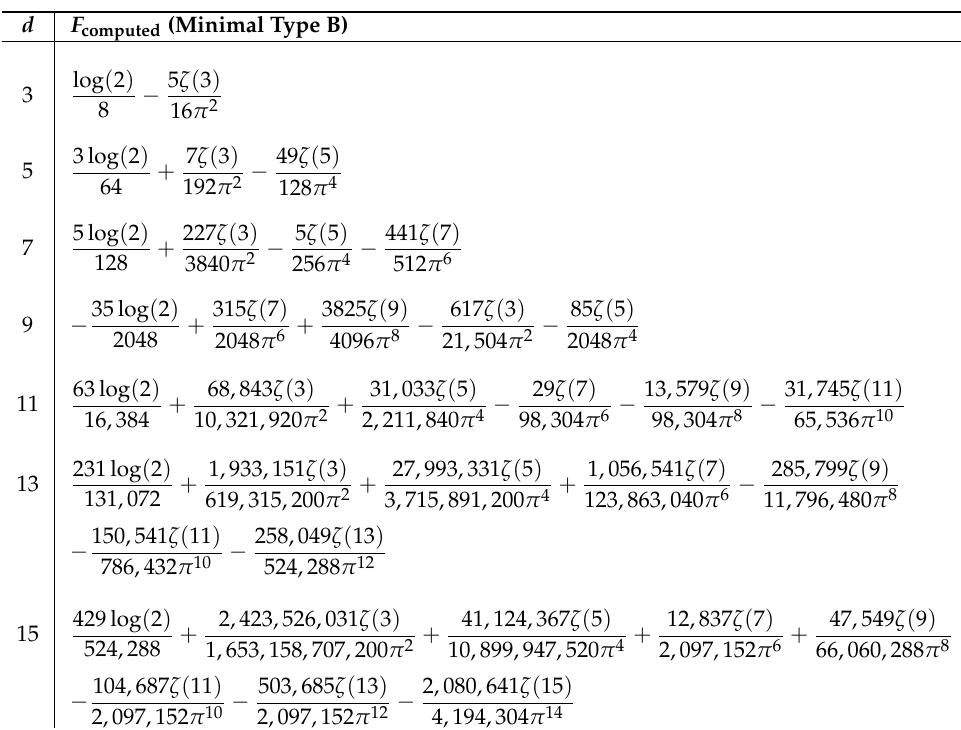
Table 6. One-loop free energy of the minimal Type B HS theory in AdS d + 1 for odd d